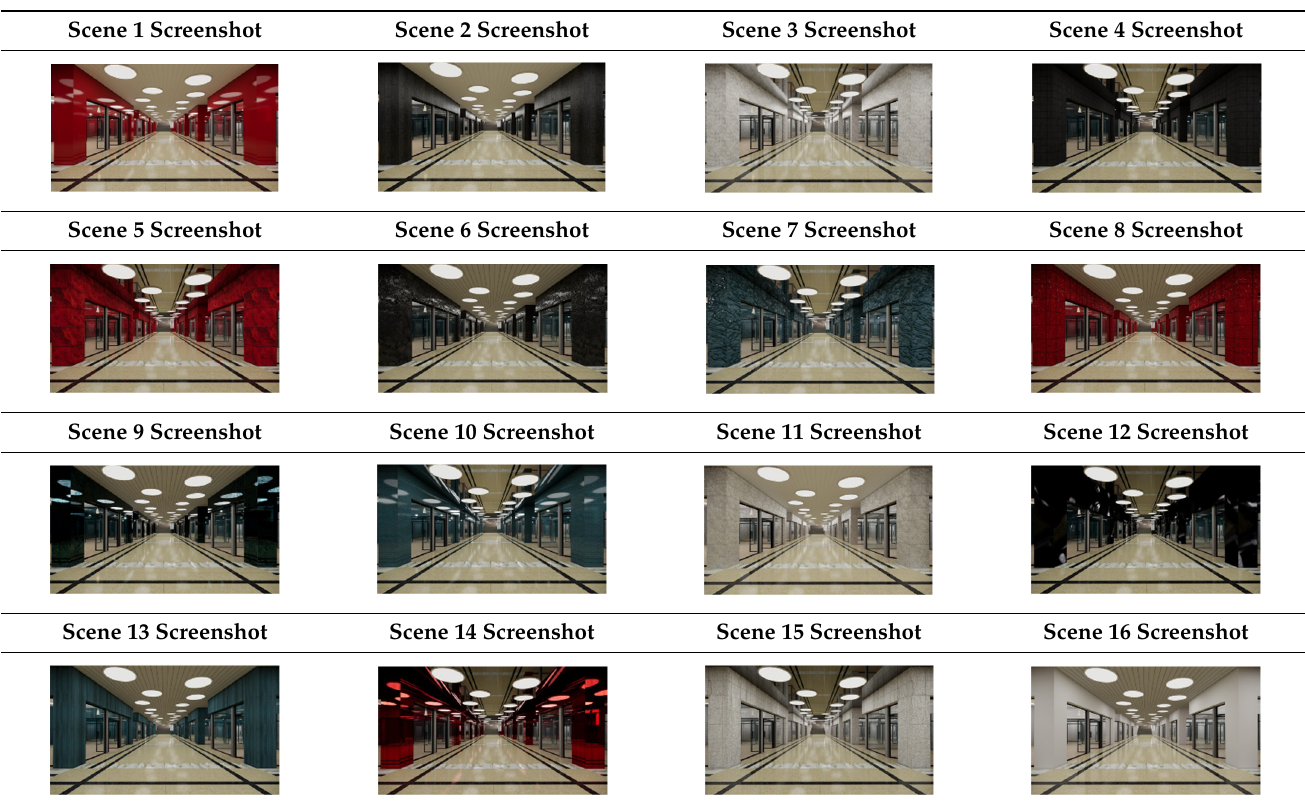
Table 5. Scene roaming